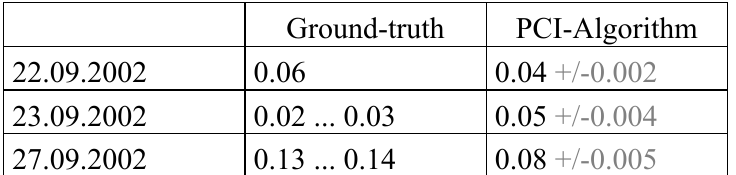
Table 9. The exemplary results for validation of the AOD estimation (750 nm) +/- : Variation over 5x5-Pixel ground-truth area on the